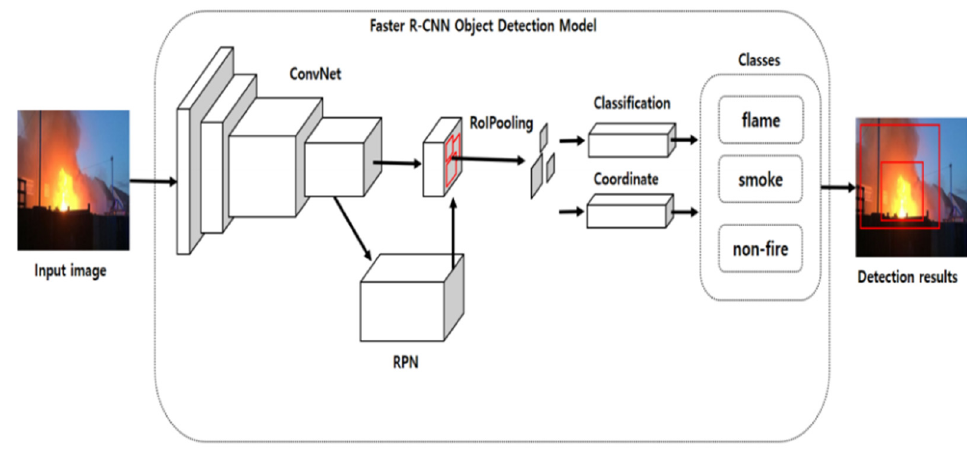
Figure 3. Faster R-CNN structure for fire detection [26].